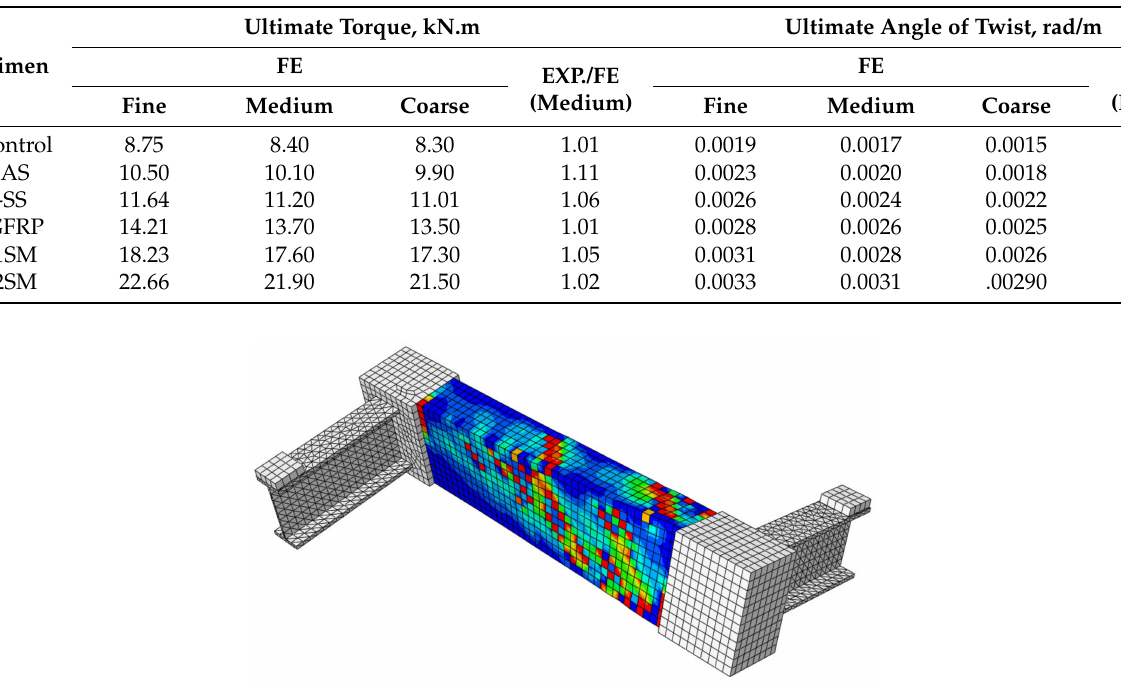
Table 10. Comparison of the experimental and finite element findings.